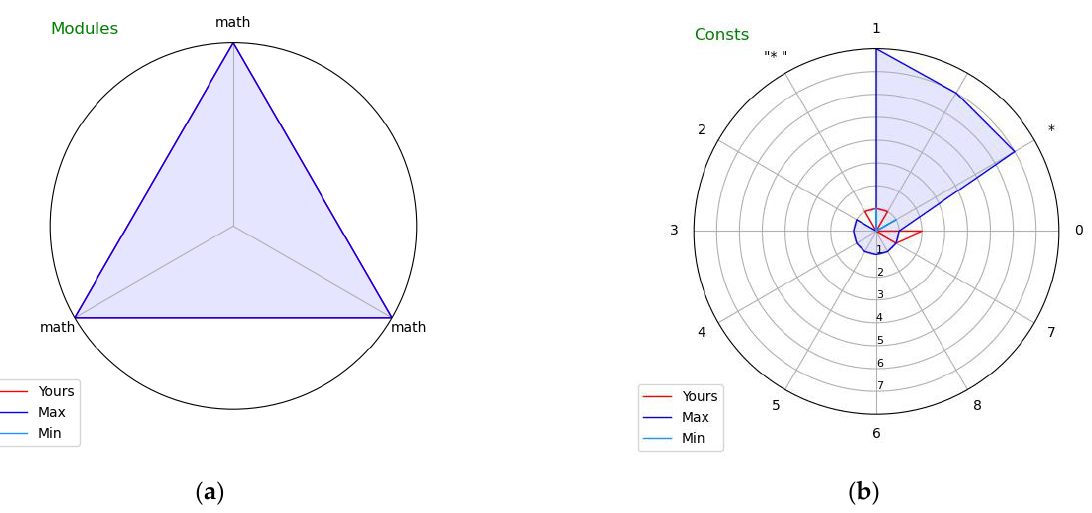
Figure 3. Visual profiles of exemplary students’ programs showing: ( a ) Modules and ( b ) Con- stants.